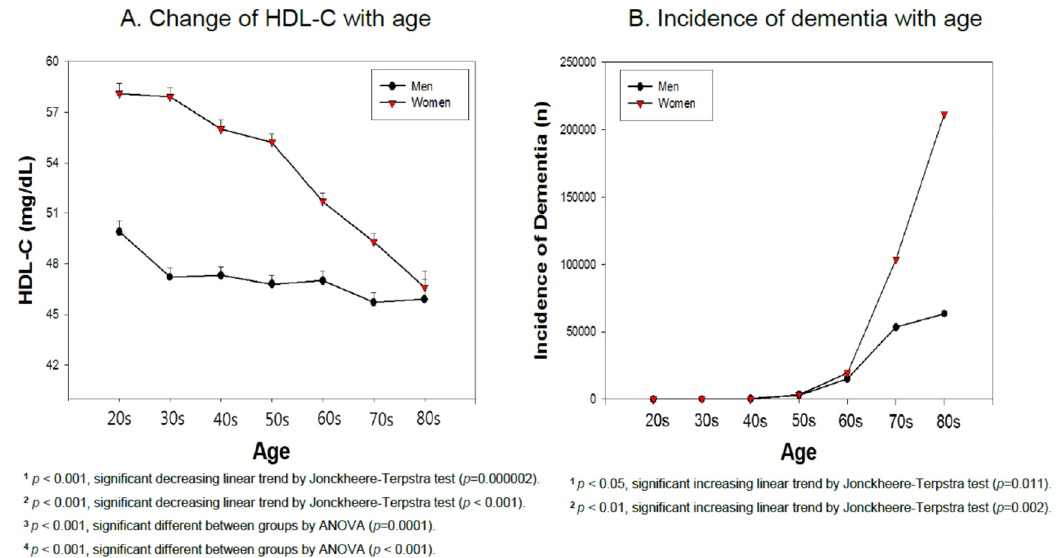
Figure 5. ( A ). Mean high-density lipoprotein cholesterol (HDL-C) levels according to age in men and women from KNHANES 2017. ( B ). Incidence of dementia according to age in men and women in 2017. The data are the mean ± SEM (Standard Error of the Mean).